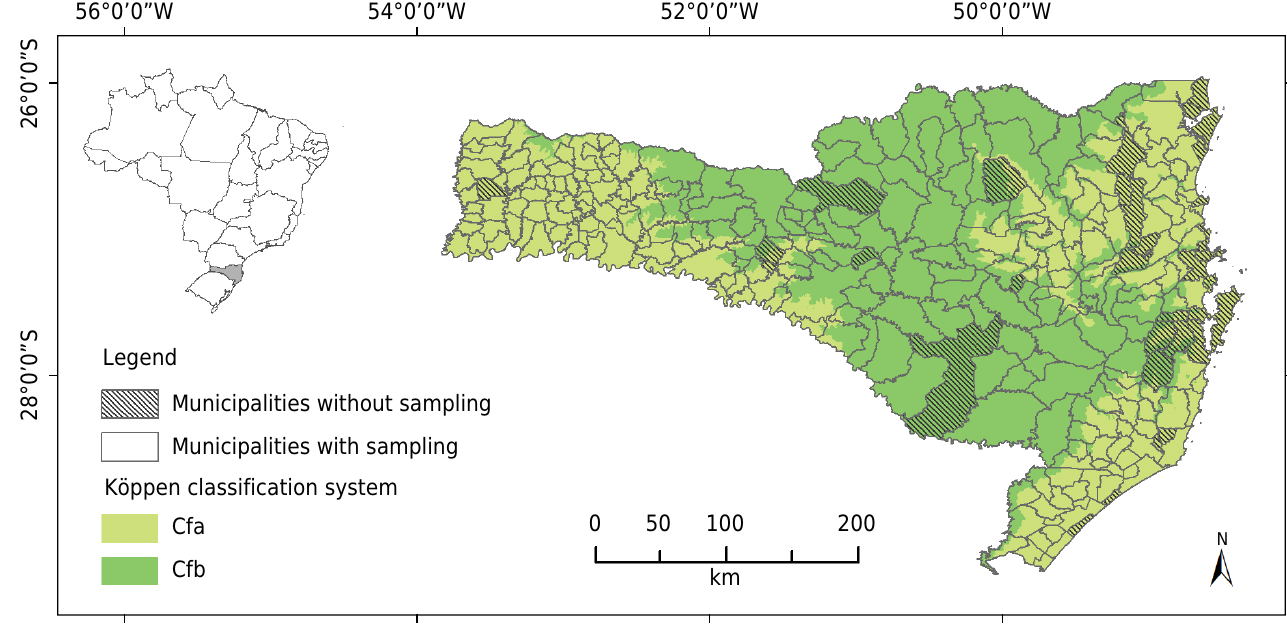
Figure 1. Sampling of soil data from municipalities of Santa Catarina